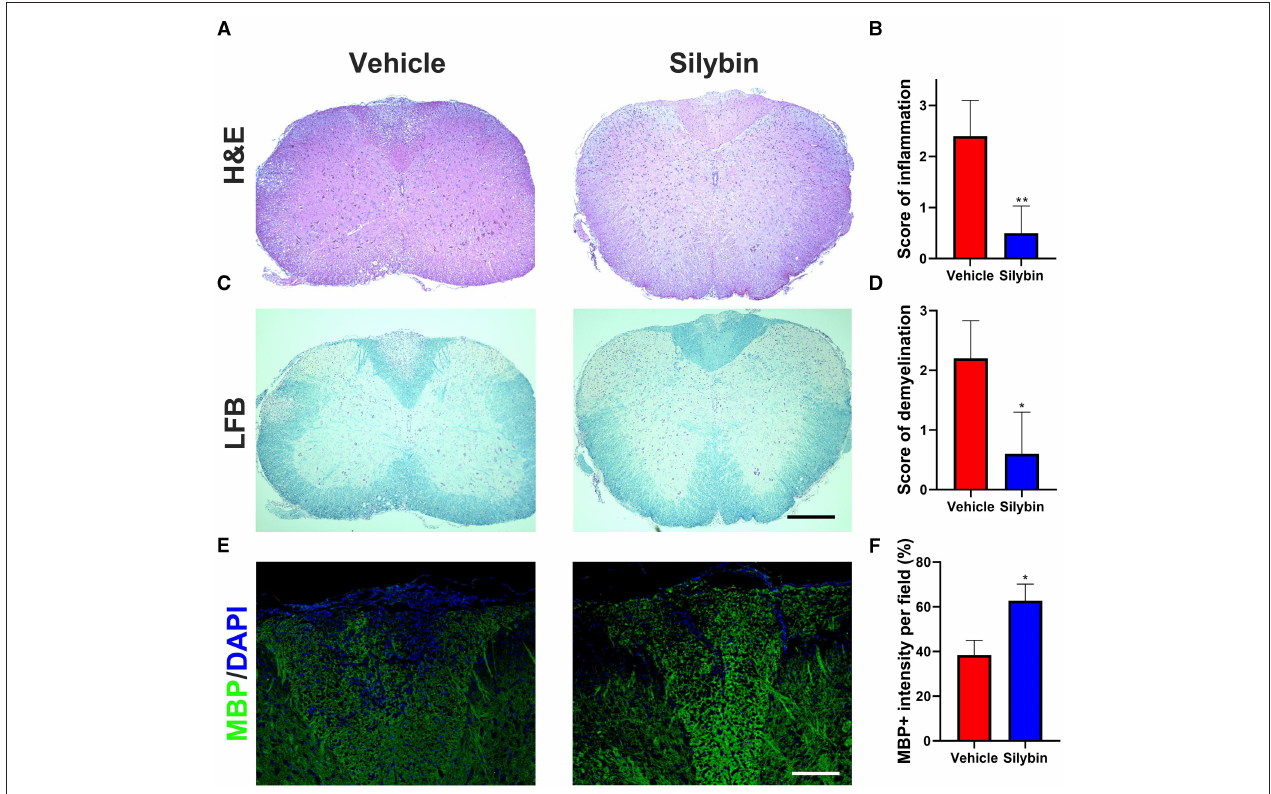
FIGURE 2 | Silybin treatment ameliorated the inflammatory cell infiltration and demyelination. (A,C) Mice were treated with silybin (10 mg/kg/day) from day 0 and sacrificed on day 21 p.i. ( n = 5 each group), and spinal cords (SCs) were harvested for H&E and luxol fast blue (LFB) staining. The white matter of the lumbar SC was analyzed to assess inflammation and demyelination. (B,D) Mean scores of inflammation in H&E-stained and demyelination in LFB-stained spinal cord sections. (E) Sections were assayed for myelinated area by myelin basic protein (MBP) staining. (F) Quantitative analysis of MBP expression. MBP intensity was measured in the lesion areas in the SCs using Image-Pro. Data represent mean ± SD ( n = 8 each group). Scale bar = 500 µ m (A,C) or 100 µ m (E) . * p < 0.05 and ** p < 0.01. Student’s t -test. One representative of three independent experiments is